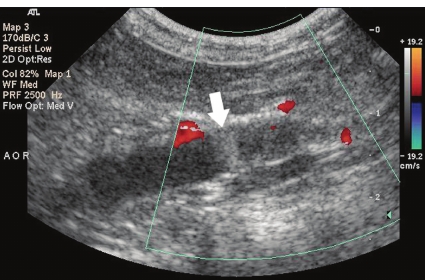
Figure 1: Abdominal ultrasound at the level of the aortic bifur- cation. The cranial portion of the dog is to the left of the image. The thrombus is hyperechoic compared to the aorta’s anechoic appearance (arrow). Color-flow Doppler application indicates blood flow extending laterally from the area of the